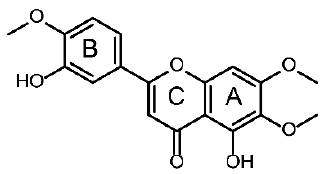
Figure 1. Chemical structure of eupatorin.